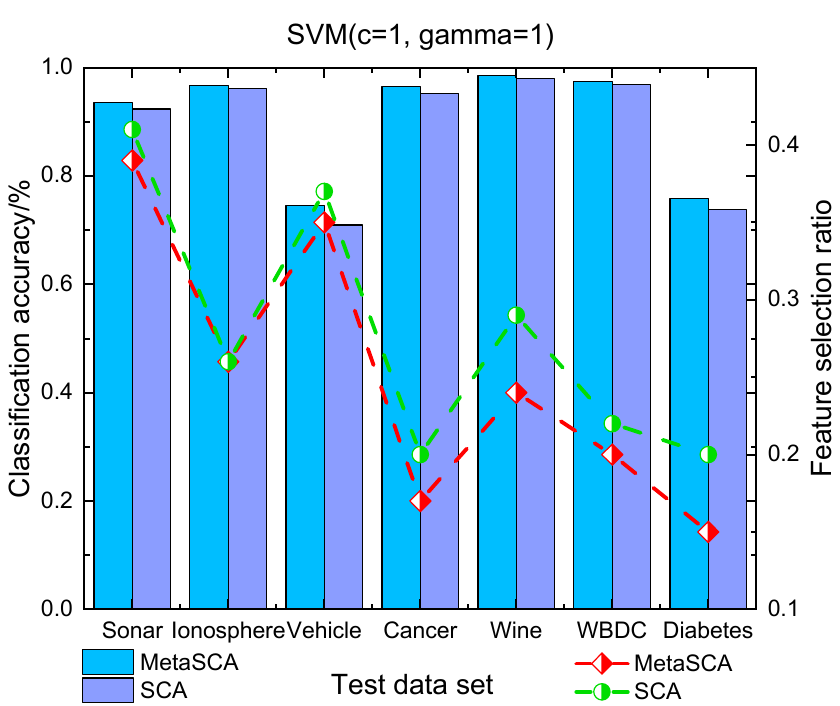
Figure 9. Classification accuracy and feature selection ratio (SVM, c = 1, gamma = 1).